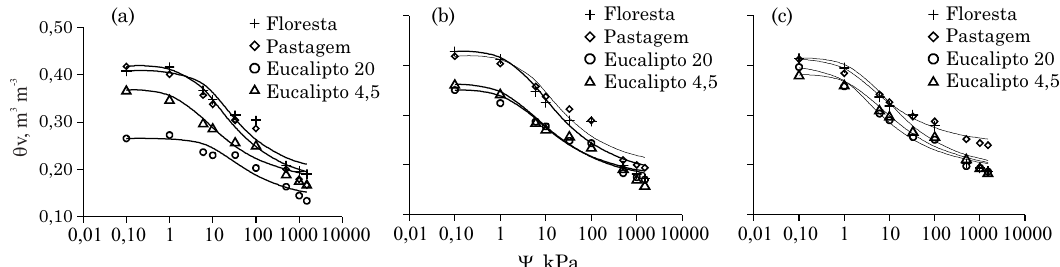
Figura 1. Valores observados (representados pelos símbolos) e estimados (representados pela linha cheia) da curva característica de retenção de água nas camadas de 0,025-0,050 (a), 0,100-0,125 (b) e 0,200-0,225 m (c) para o Argissolo Vermelho